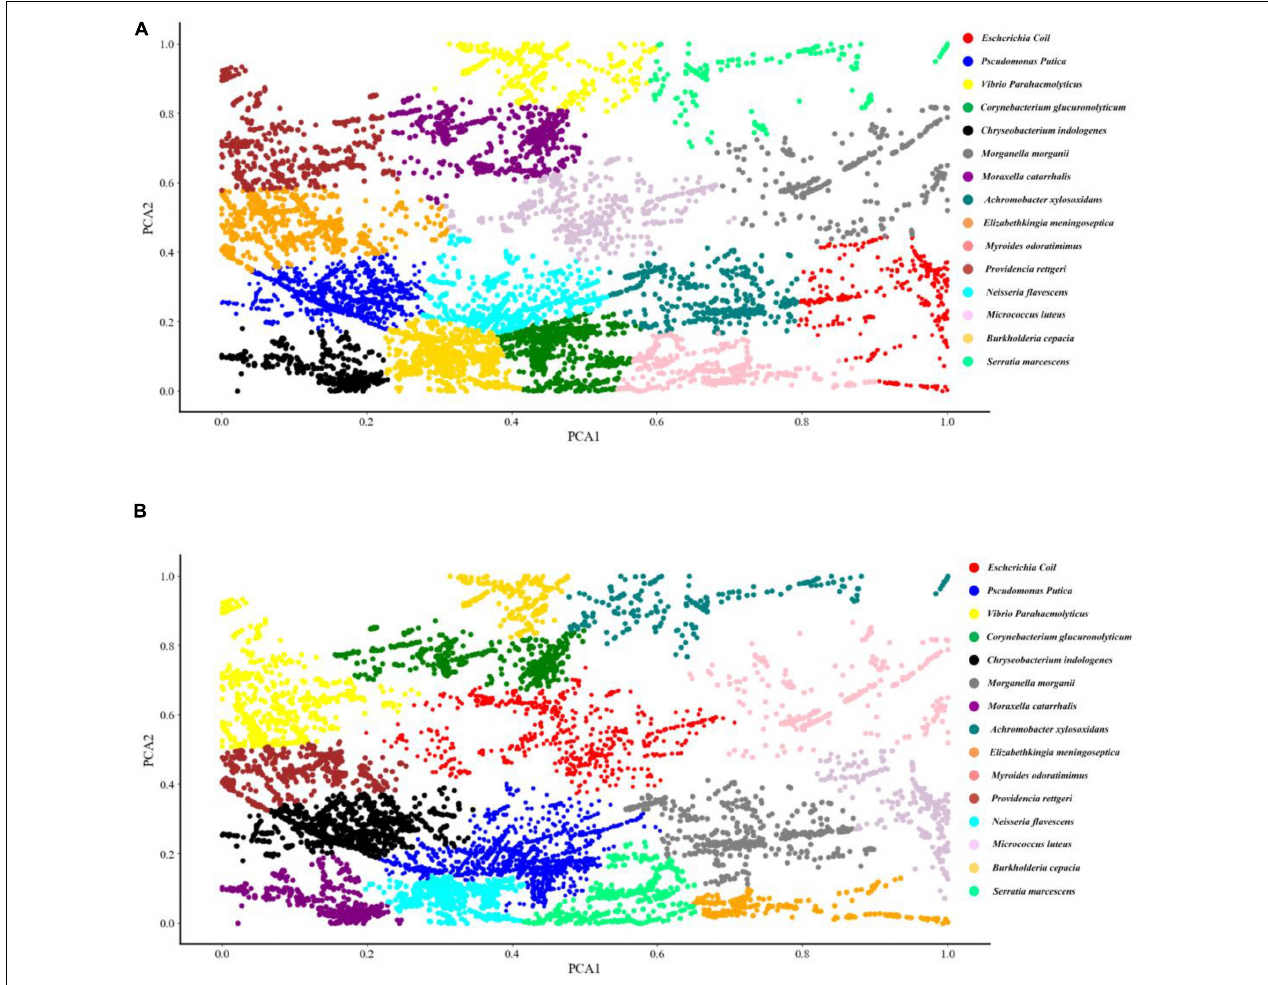
FIGURE 3 | Schematic illustration of the clustering results of 15 bacterial pathogens used in this study via K-means and agglomerative nesting (AGNES). (A) K-means. (B) AGNES. Dots with different colors represented different bacterial pathogens as indicated by the figure legends on the right.